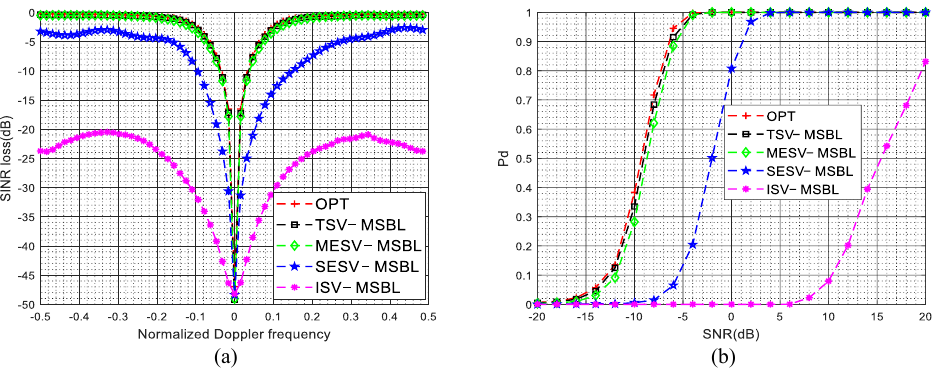
Figure 6. SINR loss curves and PD versus SNR curves in the presence of mutual coupling. ( a ) SINR loss versus the normalized Doppler frequency in the presence of mutual coupling; ( b ) PD versus SNR ( f st = 0.1) in the presence of mutual coupling.